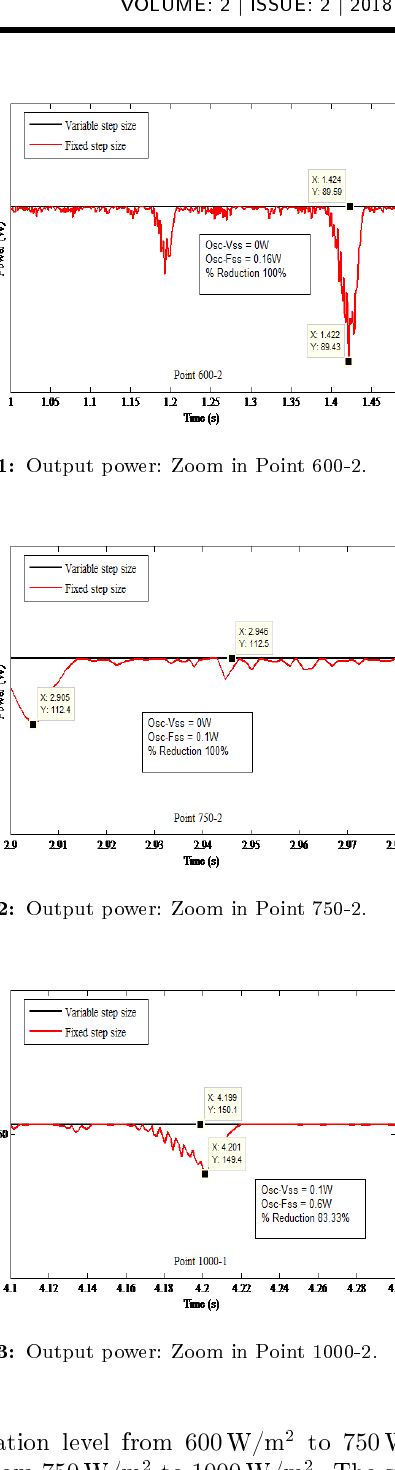
irradiation level from 600 W/m 2 to 750 W/m 2 and from 750 W/m 2 to 1000 W/m 2 . The steady state oscillation reduction ratio using the pro- posed variable step size PO MPPT is between 83.33% and 100%. C) Course Around